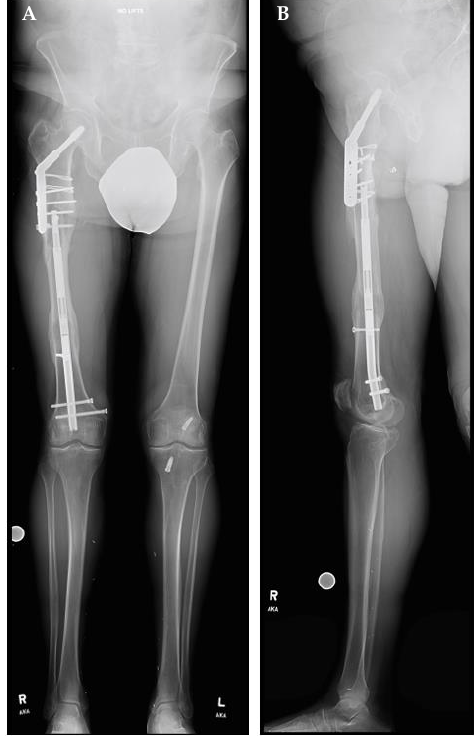
Figure 4. Post-traumatic femoral lengthening in a 71-year-old male patient at his final follow-up appointment. ( A ) Anteroposterior bilateral long leg and ( B ) lateral right long leg after consolidation of regenerate, with Precice MILN in place. Gray dots on the bottom represent X-ray calibration spheres.